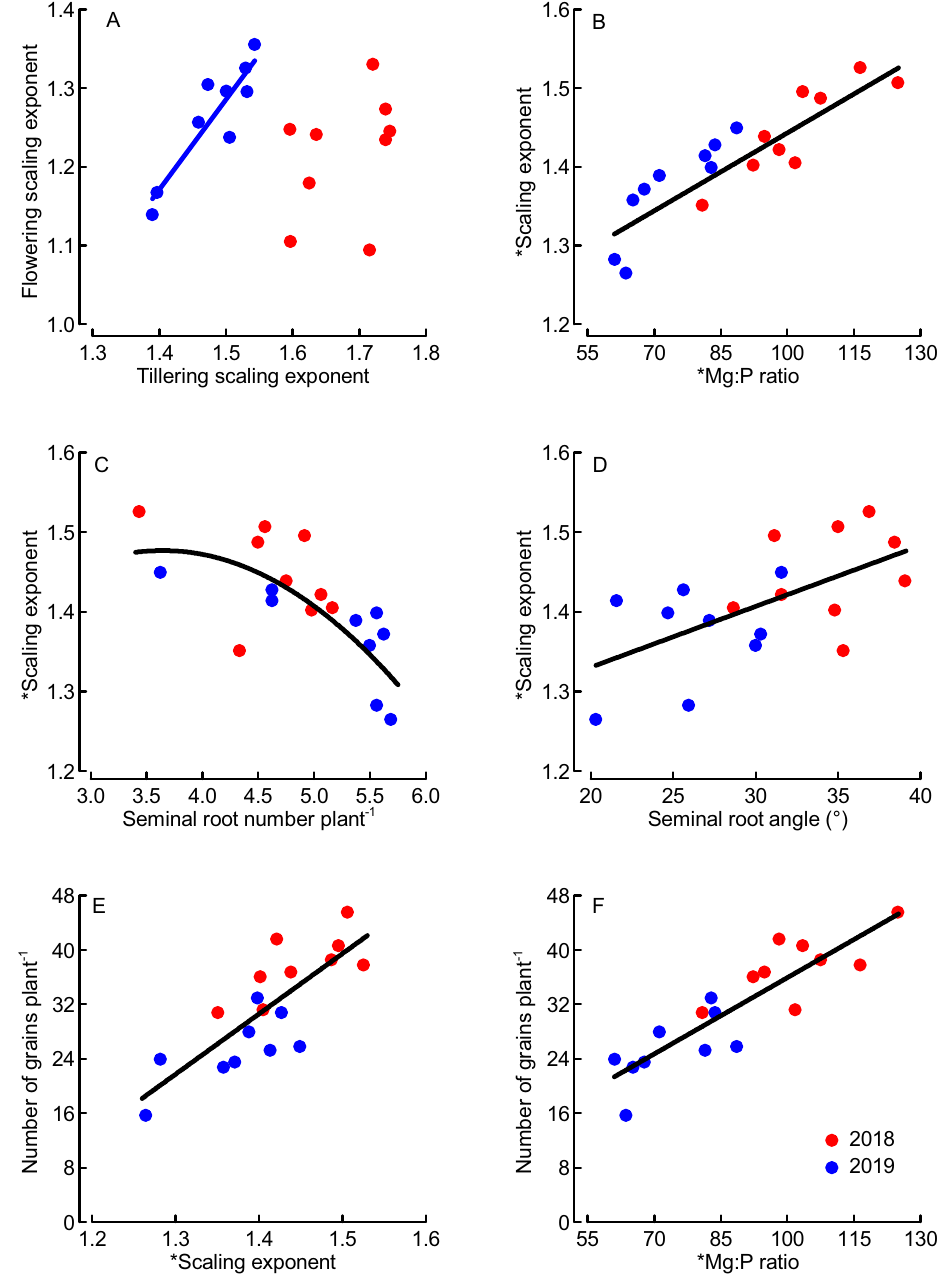
Figure 4. Relationships between scaling exponents (macroelements) and/or nutrient ratios at tillering (BBCH29) and flowering (BBCH65) 35 , root traits at tillering and number of grains per plant at maturity across nine wheat varieties field-grown in Sweden during two years (2018, 2019). *Indicates that scaling exponents were based on data from tillering and flowering. Regressions: y = 0.426x + 0.501, N = 9, R 2 = 0.13, P = 0.345 n.s. ( A , 2018); y = 1.148x − 0.436, N = 9, R 2 = 0.82, P = 0.001 ( A , 2019); y = 0.003x + 1.113, N = 18, R 2 = 0.78, P < 0.001 ( B ); y = − 0.038x 2 + 0.277x + 0.972, N = 18, R 2 = 0.47, P = 0.002 ( C ); y = 0.008x + 1.178, N = 18, R 2 = 0.36, P = 0.009 ( D ); y = 88.66x − 93.55, N = 18, R 2 = 0.63, P < 0.001 ( E ); y = 0.374x − 1.48, N = 18, R 2 = 0.77, P < 0.001 ( F ). Dots represent means from 4